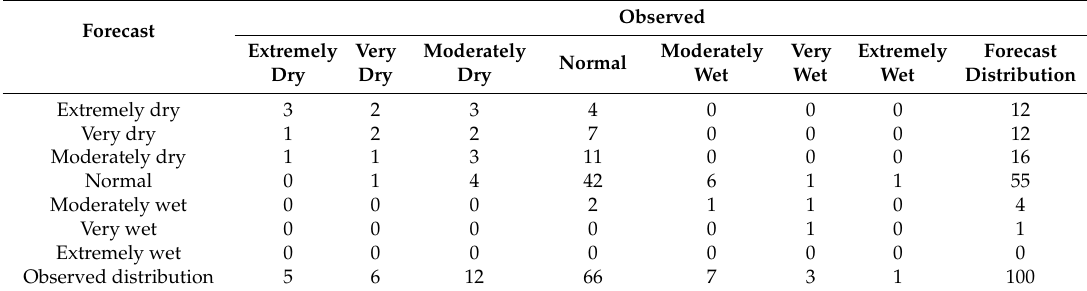
Table 3. Relative frequency (in percent) for SPI 20-day forecasts ( n =